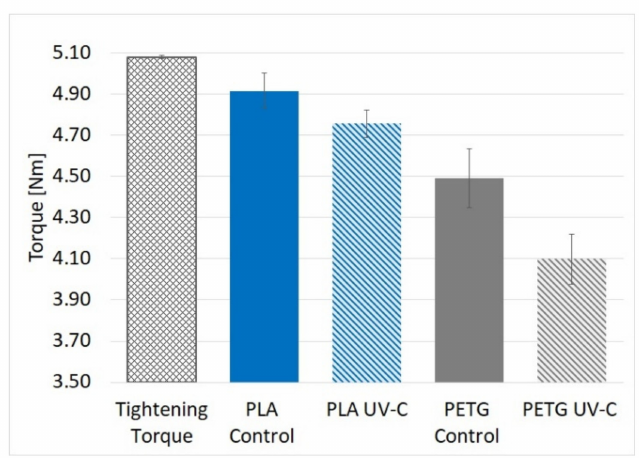
Figure 8. Results of compression creep practical test.